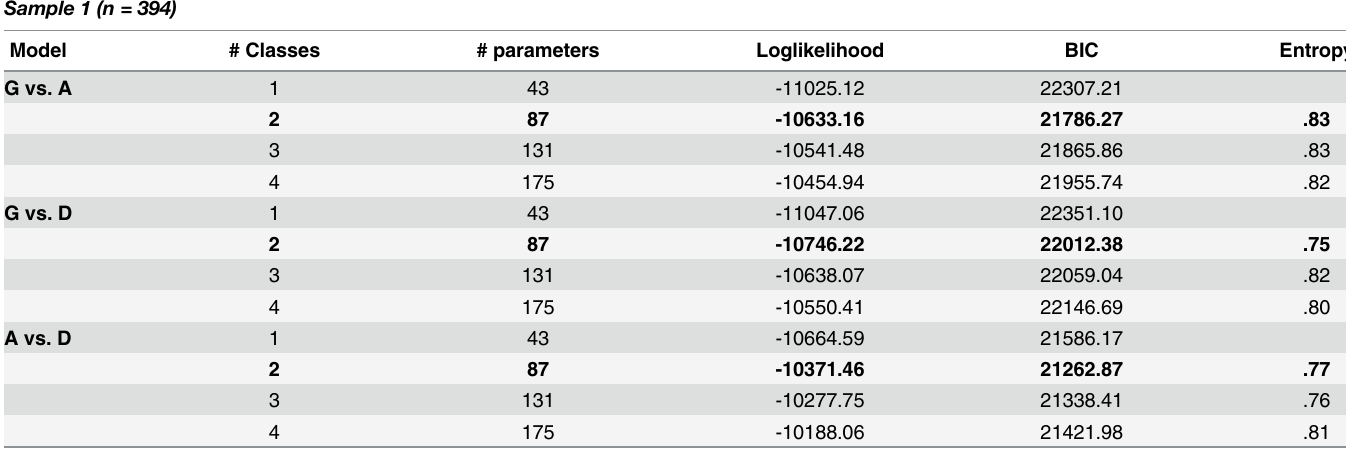
Table 3. Goodness of fit of competing LCA models for Behavioral Tendencies Questionnaire (original 43-block version). Sample 1 (n = 394)